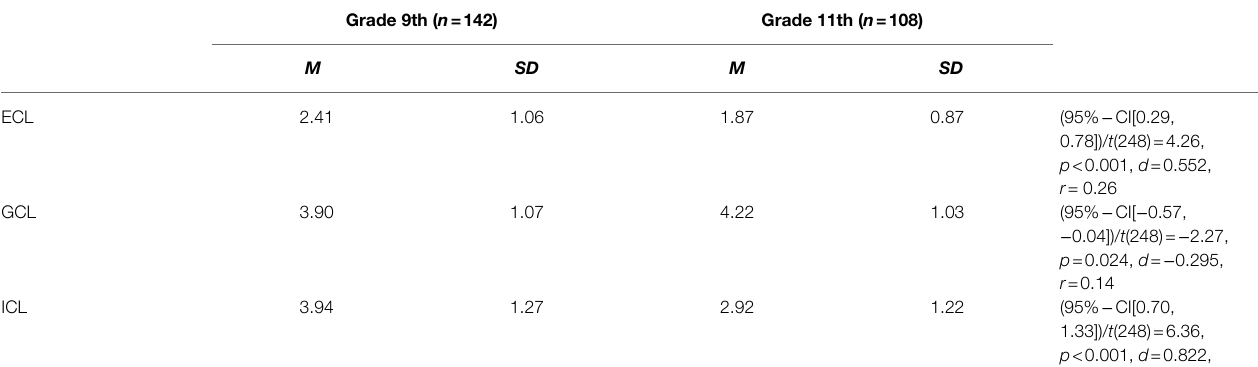
TABLE 4 | Differences between 9th and 11th grade in cognitive load ( t -test, n = 250).